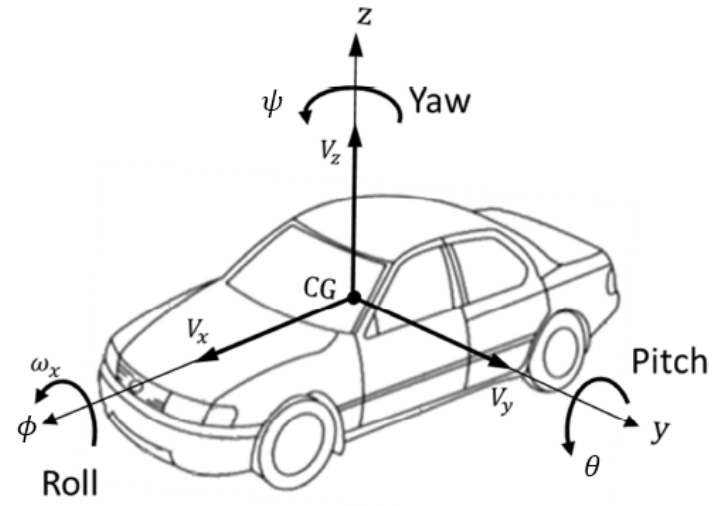
Figure 1. Vehicle Axis System ISO